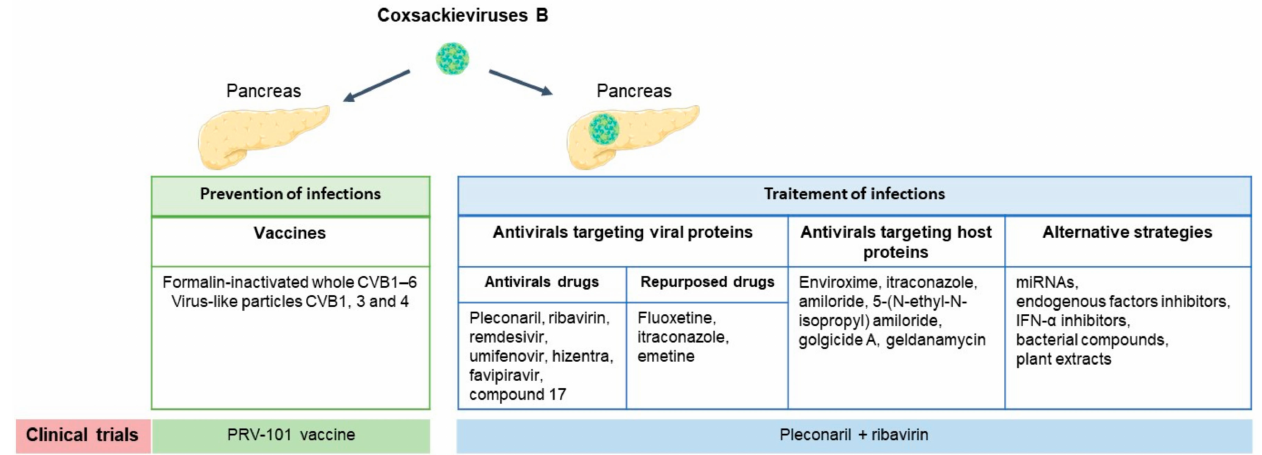
Figure 1. Antiviral strategies for the prevention or treatment of type 1 diabetes (T1D) induced by en- teroviruses (EVs) infections, especially coxsackieviruses B (CVB). Vaccines against CVB administered to newborns or children before exposure to viruses could be effective for the primary prevention of T1D. Antiviral drugs targeting viral or host proteins could be administered to susceptible individuals already exposed to multiple, recurrent or persistent infections in order to prevent or reduce the risk of appearance of islet autoimmunity and/or preserve β -cell function among newly and established diagnosed T1D patients. Alternative strategies targeting miRNAs, endogenous factors or based on natural products should be explored to fight EVs